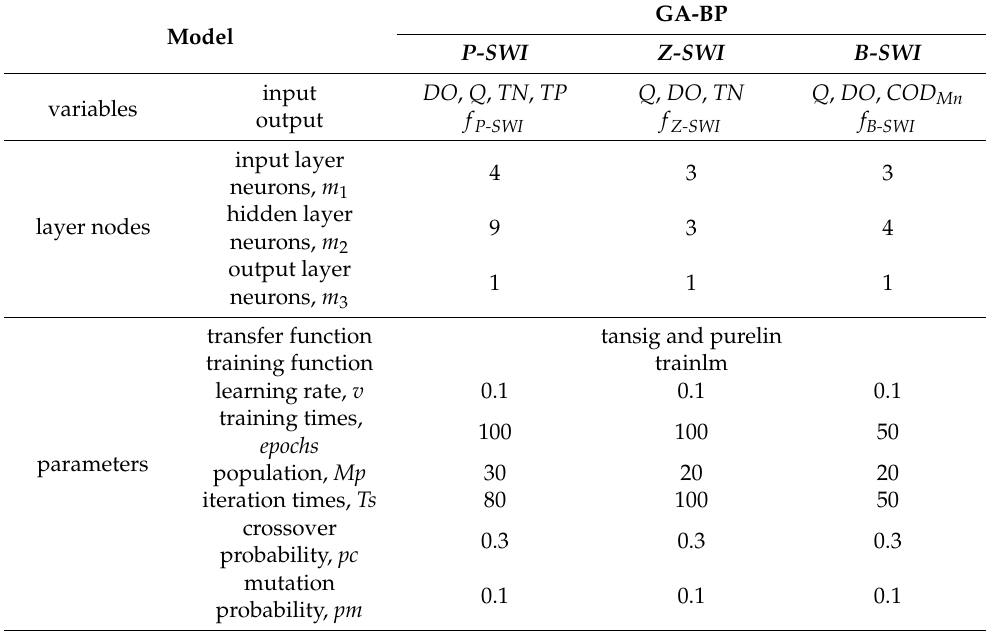
Table 4. Structure and parameter settings of GA-BP